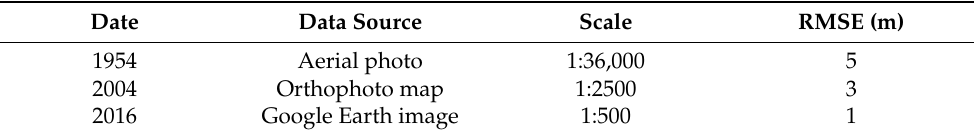
Table 2. Data sources used to calculate the shoreline variations in the test areas. RMSE = root mean square